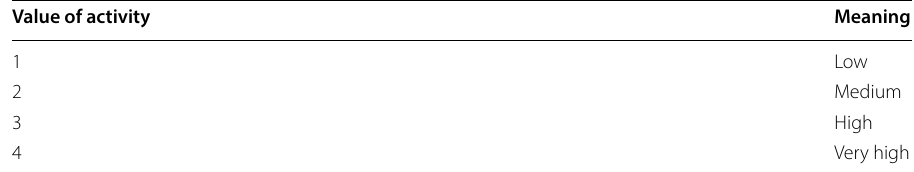
Table 5 Description of activity’s values Value of activity